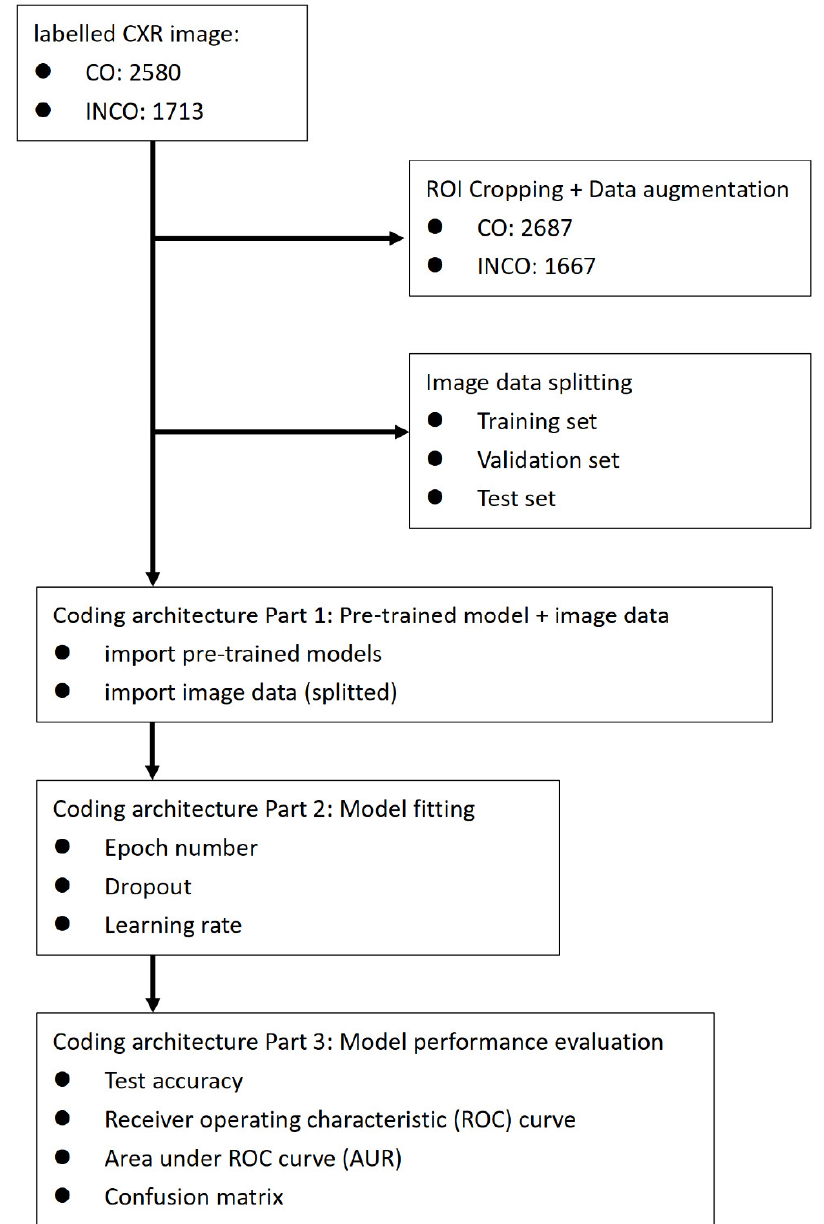
Figure 1. Flowchart of image data preparation, coding architecture, and evaluation of model fitness. CO: correct position of endotracheal tube. INCO: incorrect position of endotracheal tube.